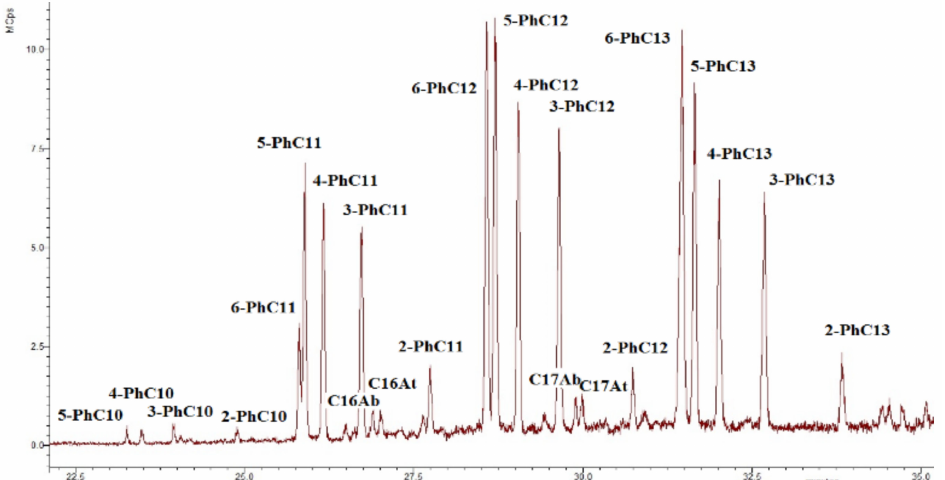
Figure 11. The chromatogram m/z 91 of the aromatic fraction of the sediment sample collected at the debris cone zone (KV1). Ph—designation of the phenyl radical; Ab—designation of the alkylbenzene; At—designation of the